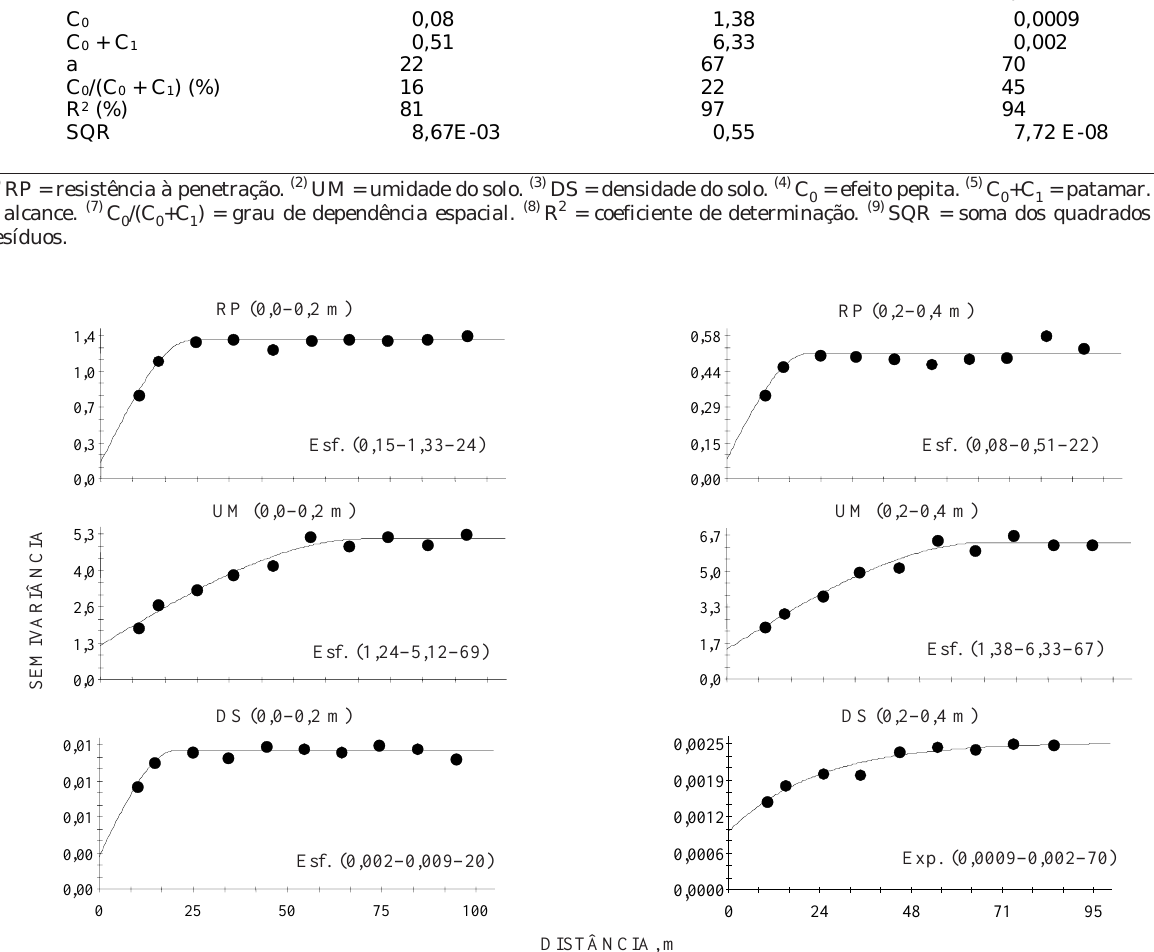
Figura 2. Semivariogramas das variáveis resistência à penetração do solo - RP (MPa), umidade do solo - UM (kg kg -1 ) e densidade do solo - DS (kg m -3 ) nas profundidades de 0,0-0,2 m e 0,2-0,4